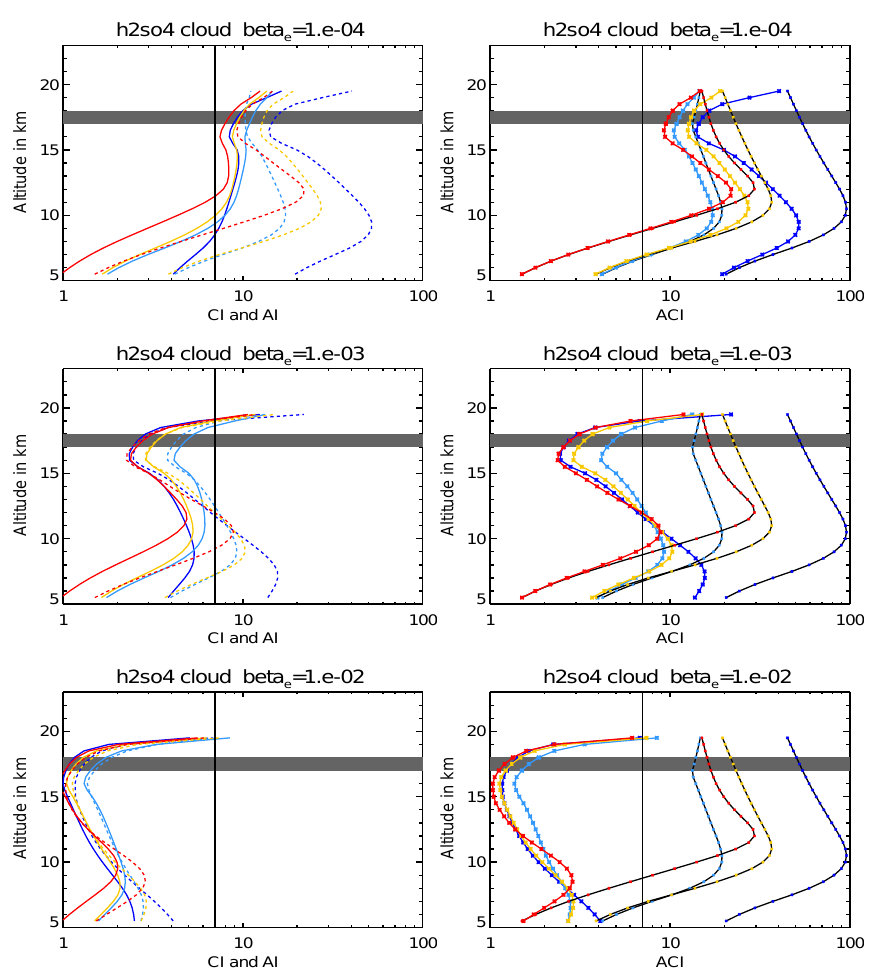
Figure A7. Same as Fig. A5 but for sulfate aerosol and the mode radius of 0.6µm.